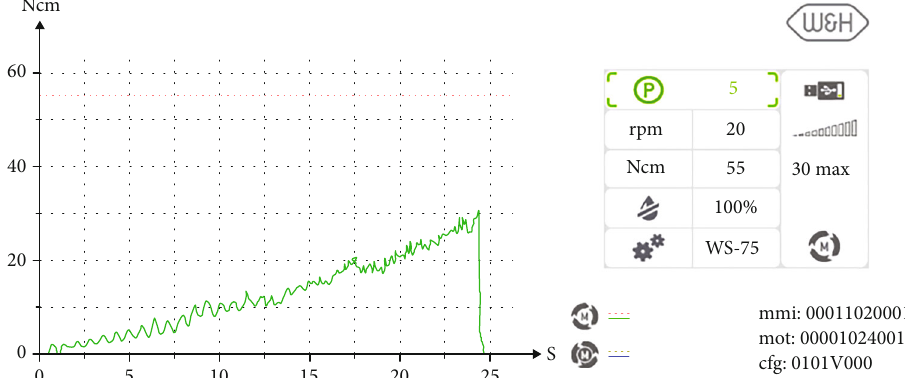
Figure 8: Insertion torque curve 36.